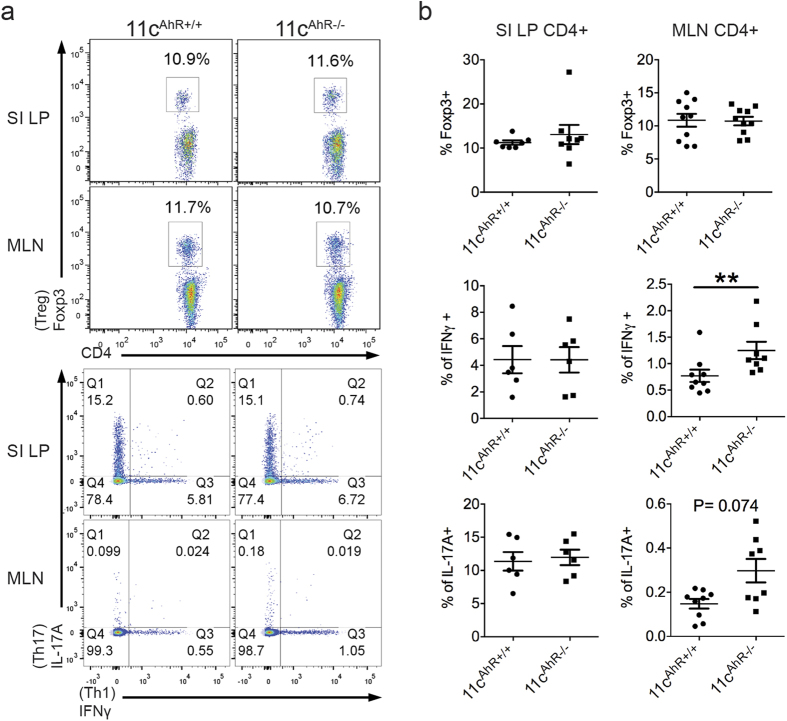
AhR-deficiency in intestinal APC subsets did not result in overt mucosal immunity.(a,b) Isolated lymphocytes from the small intestinal LP or the MLN re-stimulated for 4 hours ex vivo. (a) Representative FACS plots showing intracellular staining for Foxp3, IFNγ or IL-17 A in CD4+ T cells. (b) Graphs illustrate mean percentages within the CD4+ population ±SEM. Each symbol represents one mouse. Data were pooled from 3–4 independent experiments. Mann-Whitney test: *P < 0.05; **P > 0.01; ns, not significant.